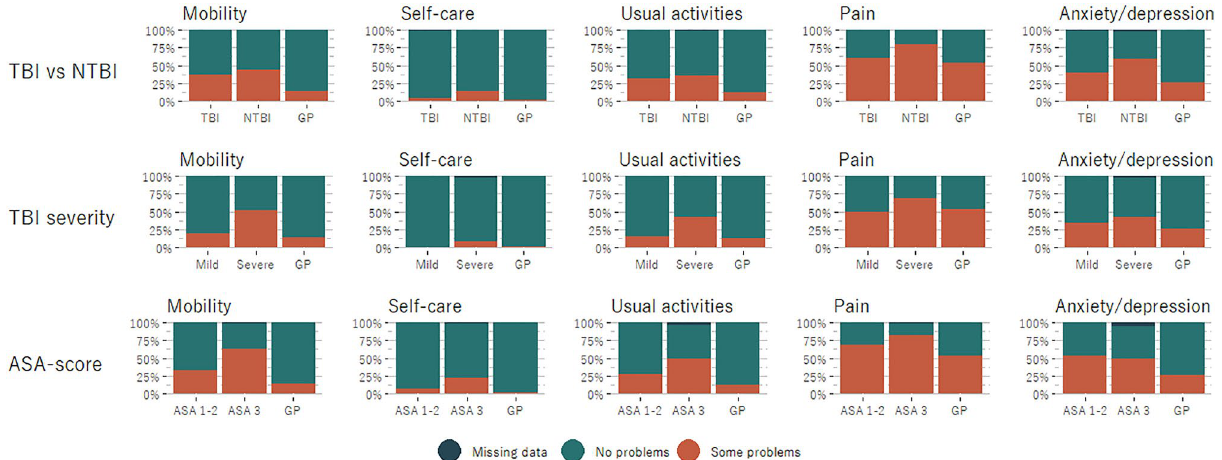
Figure 3. Problems reported by EQ-5D-3L dimension dichotomized into “no problems” and “some problems”. Comparing trauma patients with a concomitant traumatic brain injury (TBI) to trauma patients without (NTBI), TBI severity defined by Abbreviated Injury Severity (AIS) head score of 3, and no or few comorbidities (ASA-score 1–2) to severe systemic morbidity (ASA-score